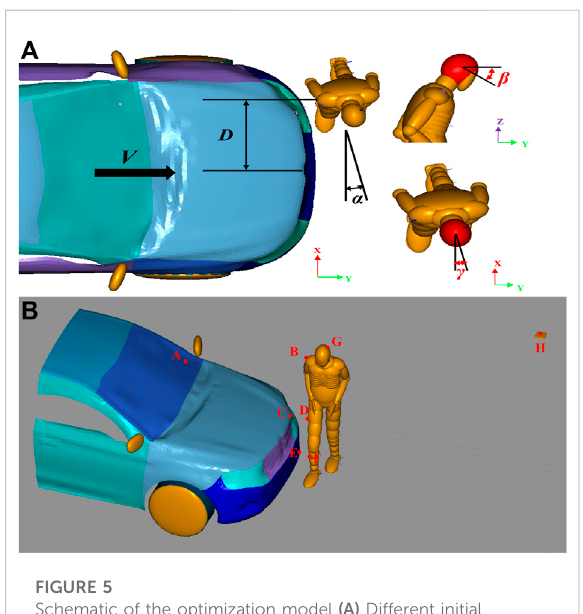
FIGURE 5 Schematic of the optimization model (A) Different initial collision parameters (optimization variables) (B) Positions of the four collision marker point